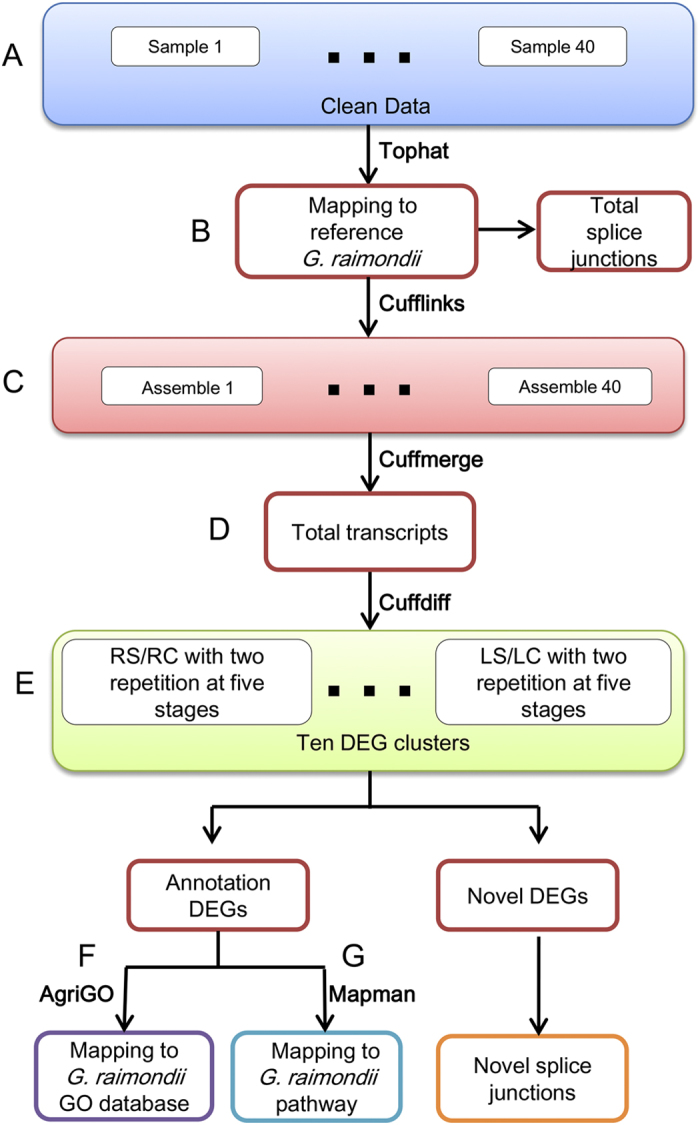
Workflow of RNA-Seq analysis.(A) Clean data sets were generated from 40 samples with two independent biological replicates of roots and leaves at five time points. (B) The reads were mapped using Tophat onto the G. raimondii genome. (C) Cufflinks was used for transcriptome reconstruction, resulting in 40 different assemblies corresponding to 40 samples. (D) Cuffmerge was used to merge the four assemblies and the reference annotations into a single consensus list of transcripts and to categorize the assembled transcripts. (E) Cuffdiff was used to identify differentially expressed genes (DEGs) under salt stress in both tissues at five time points. (F) AgriGo was used to identify enriched GO terms. (G) Mapman was used to enrich DEGs in the pathway related to salt stress.